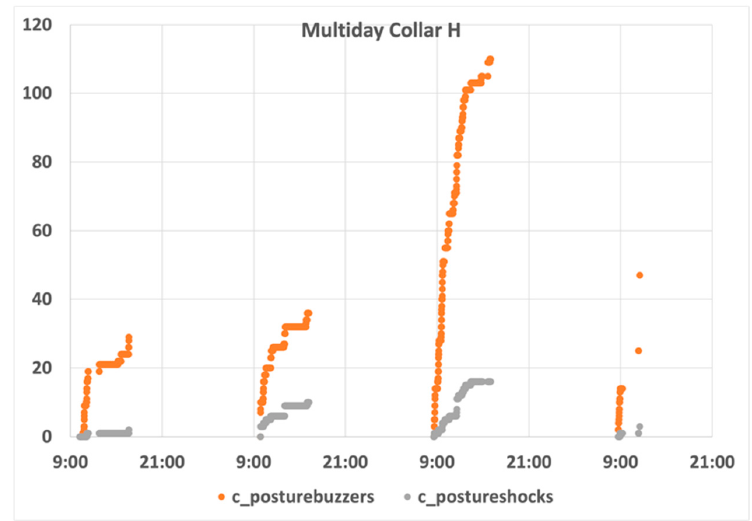
Figure 13. Collar H behaviour analysis.